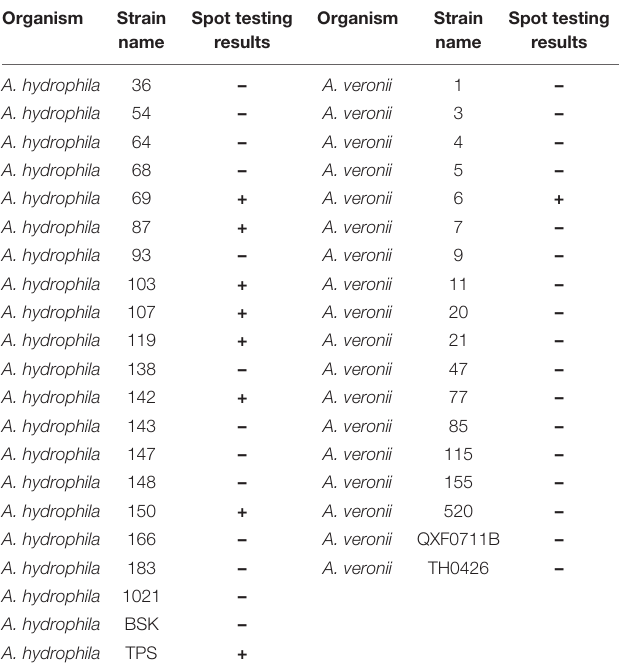
TABLE 1 | Bactericidal spectrum of